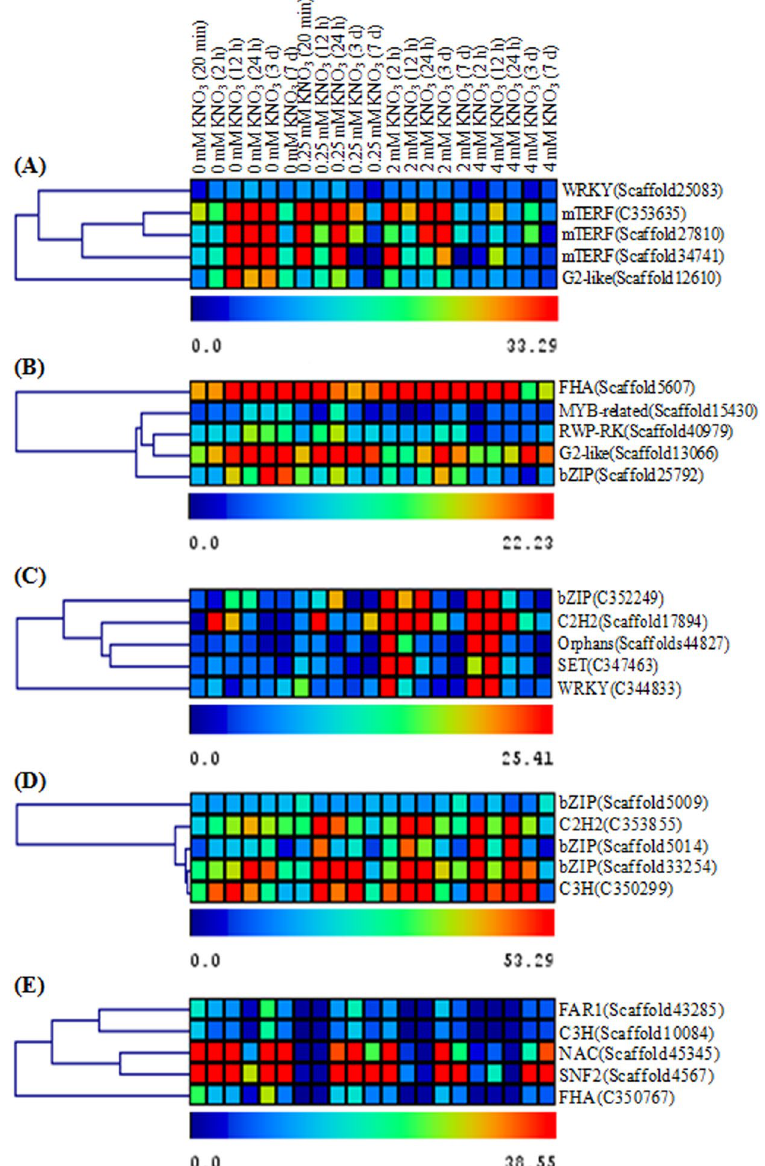
Figure 6. Nitrate regulatory modules and HUB TF genes in B . juncea : Four nitrate regulatory modules in PB named as Darkred, green, Royalblue, yellow ( A – D ) and one in PJK named as blue module ( E ) are identified. Based on the connectivity (K) and gene significance (GS), top-5 HUB TFs are identified in each module. The differential expression patterns of these HUB TFs under control and treated conditions are